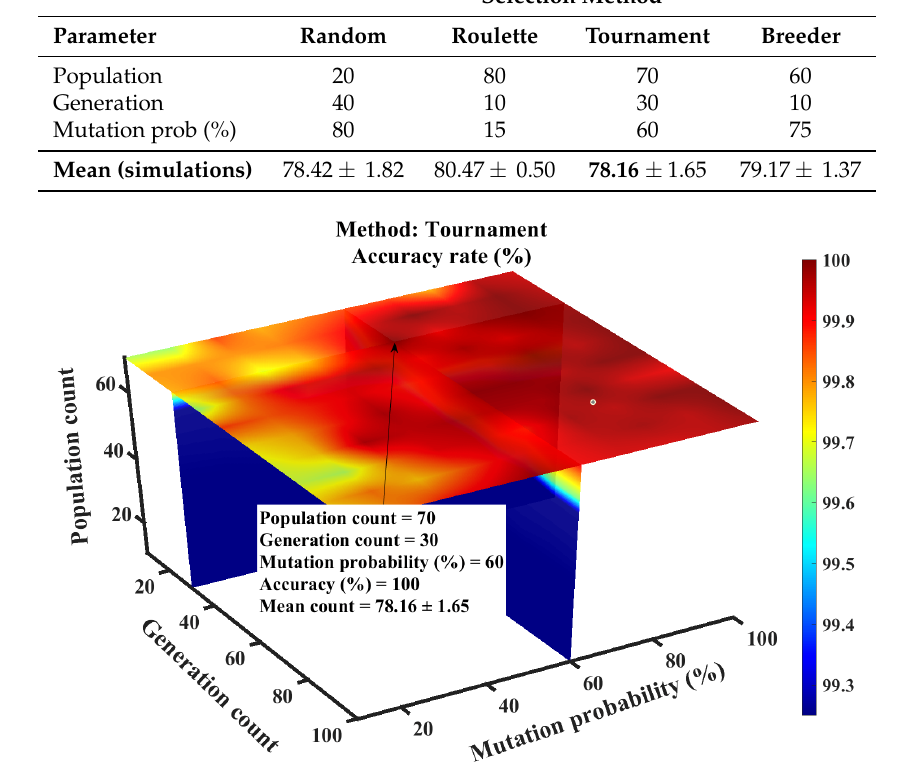
Figure 7. Single ZnO layer optimization using GA with tournament selection: accuracy (%) distribution data sliced at population size of 70, generation count of 30, and mutation probability of